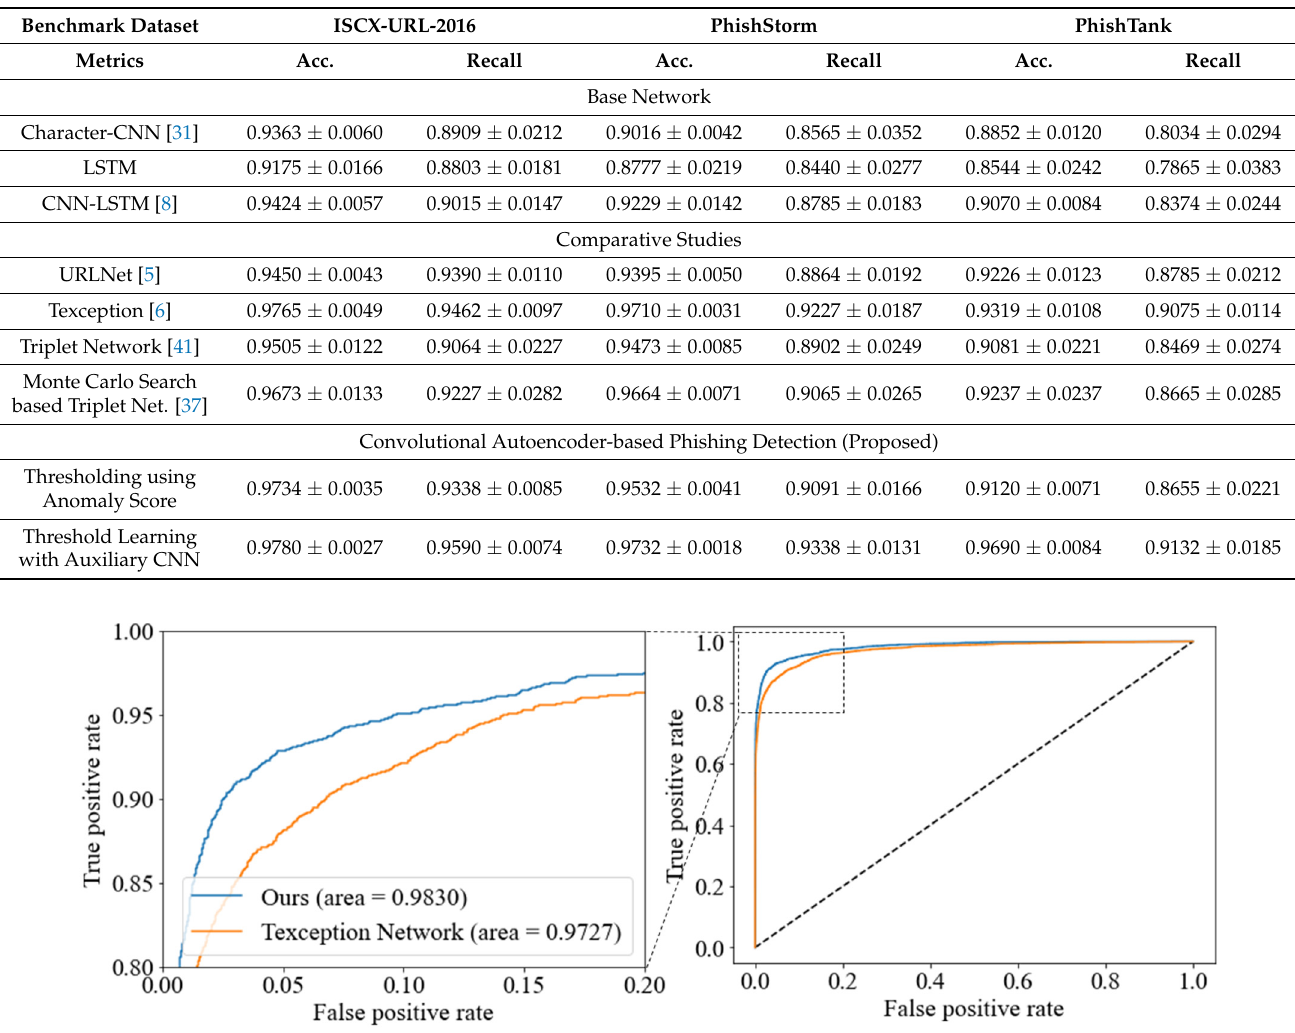
Table 4. Comparison of 10-fold cross-validation in terms of accuracy and recall.